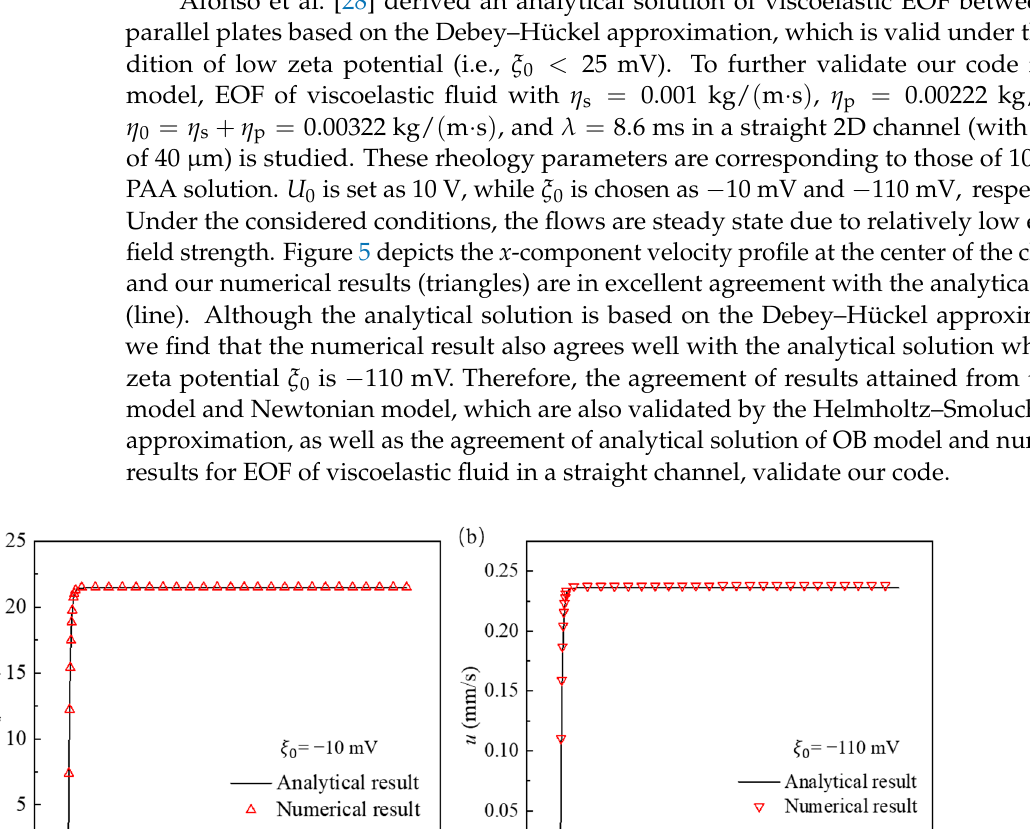
Figure 5. The x -component velocity profile of viscoelastic electroosmotic flow (EOF) between two parallel plates: ( a ) Zeta potential is − 10 mV; ( b ) zeta potential is − 110 mV. Analytical result of Afonso et al. [28] (solid line) and current numerical result (symbol). The analytical solution is described in Appendix